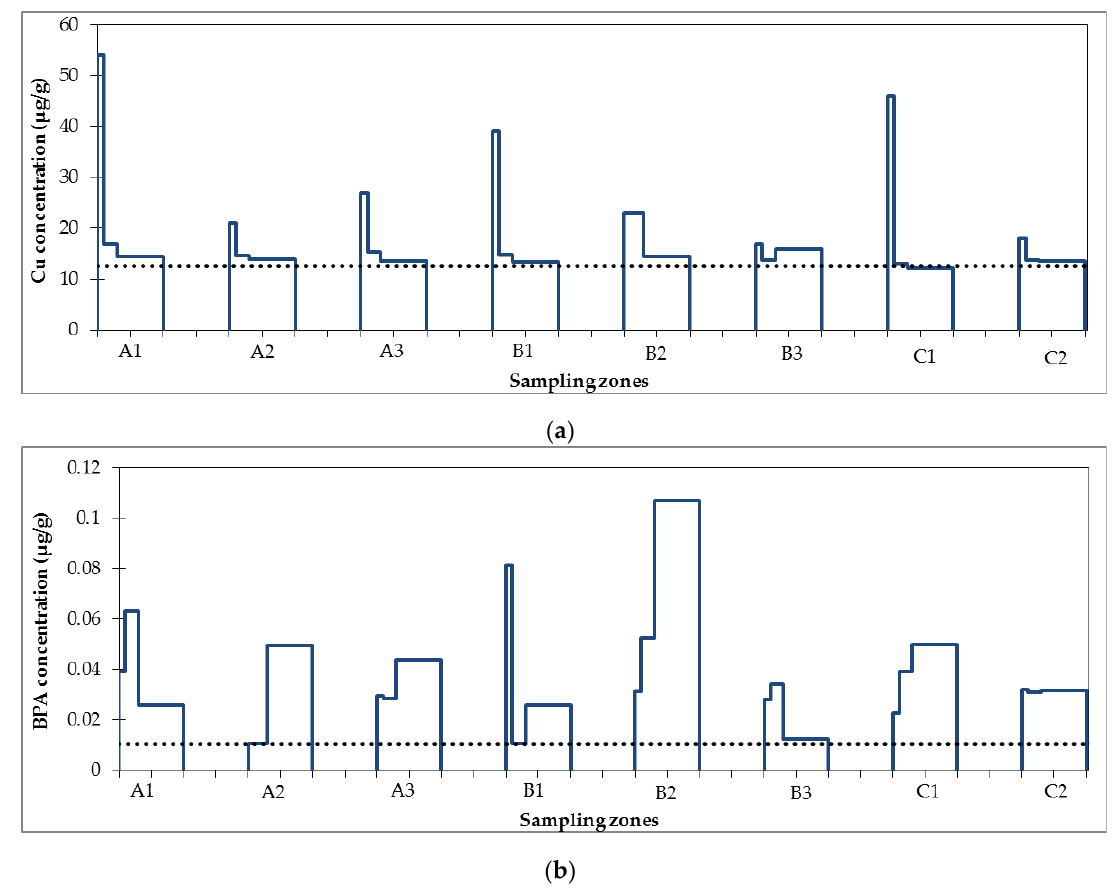
Figure 5. Concentrations of ( a ) copper and ( b ) bisphenol-A (BPA) measured in composite cores of each sampling zone. Within each zone, concentrations from cores taken at depths of 0–5 cm, 5–15 cm and 15–50 cm are represented to scale from left to right. The dotted line represents the concentration measured in the initial soil sample.